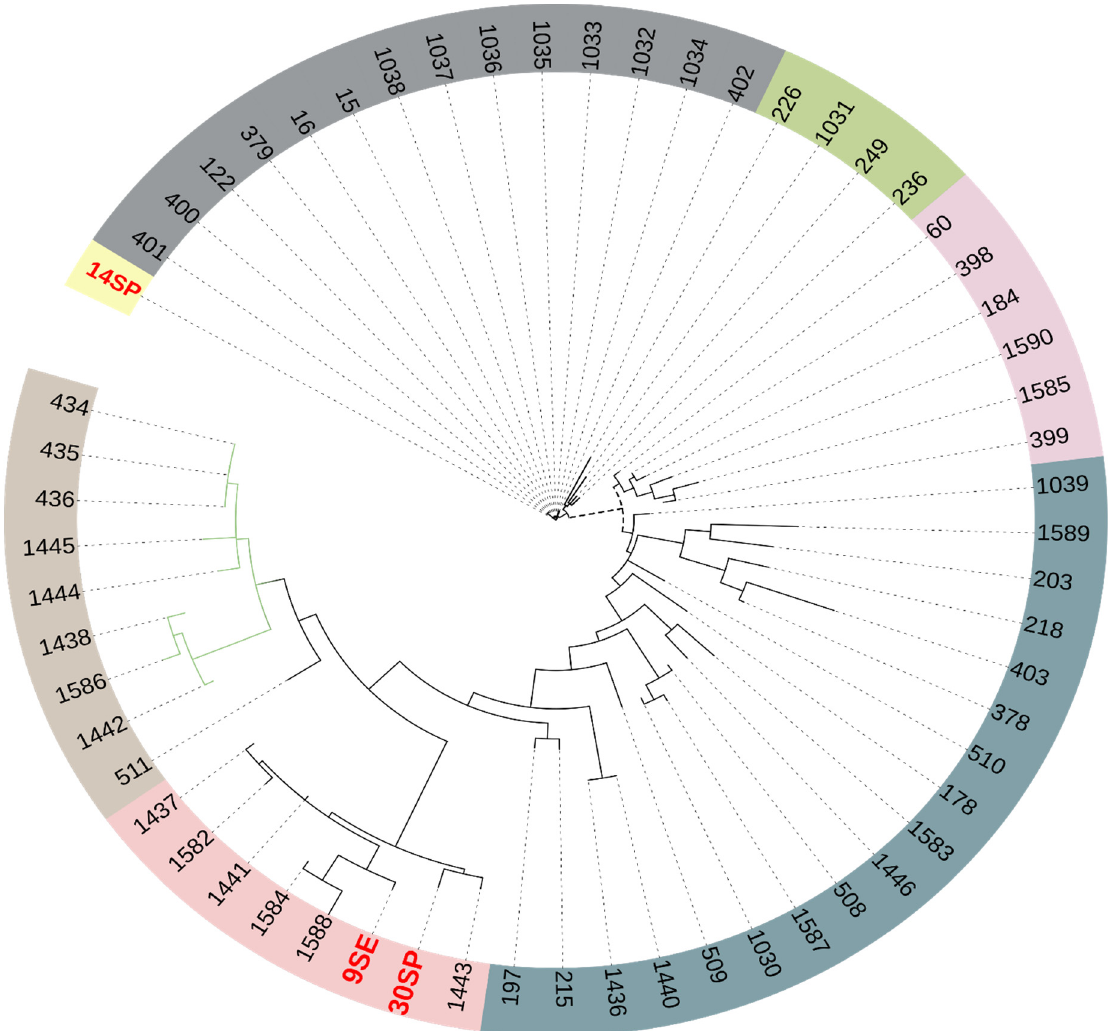
Figure 3. Circular representation of the maximum likelihood phylogenetic tree of S. epidermidis , including 9SE, 14SP, and 30SP in red, and the most related strain (57) of S. epidermidis submitted from Africa in the PubMLST database. Different clades shown in different colors.